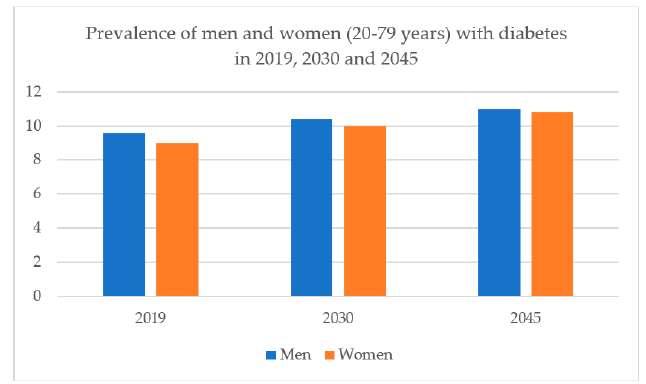
Figure 2. Prevalence of men and women (20–79 years) with diabetes in 2019, 2030 and 2045.